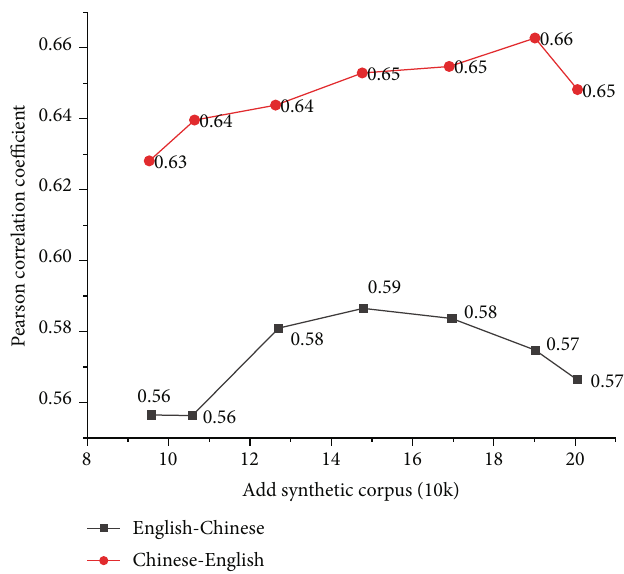
Figure 7: Add synthetic (mono-zh) corpus experimental results.